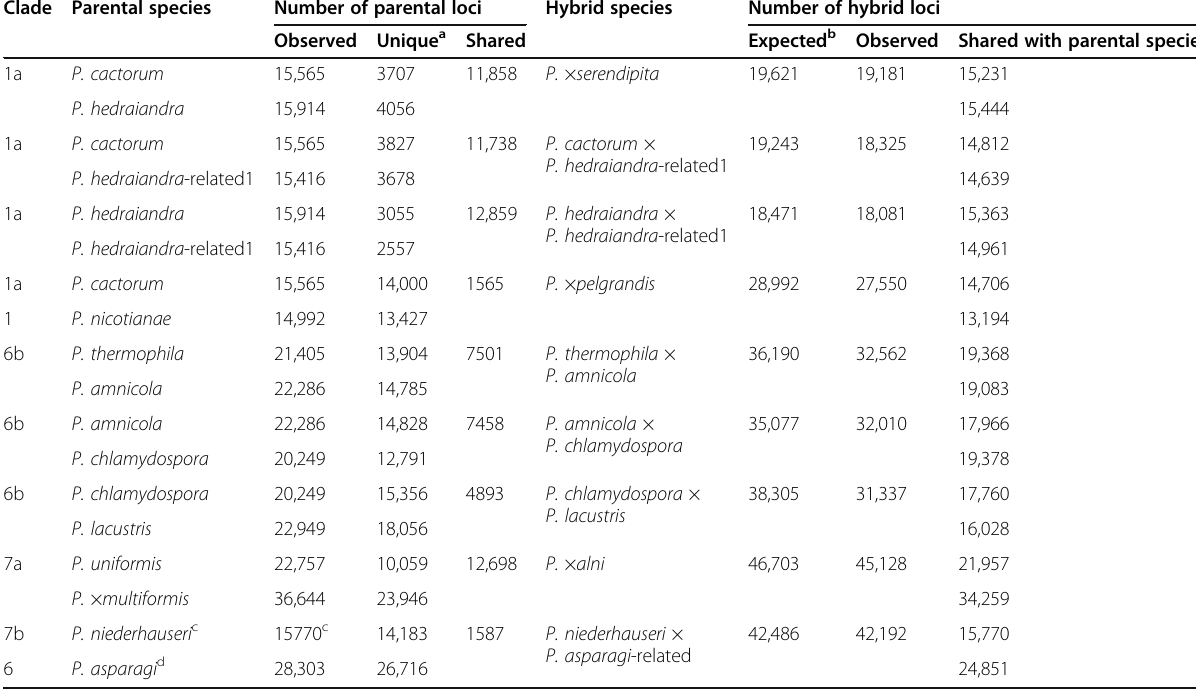
Table 2 Comparison of expected and observed numbers of GBS loci of selected hybrid Phytophthora species in clades 1, 6 and 7 Clade Parental species